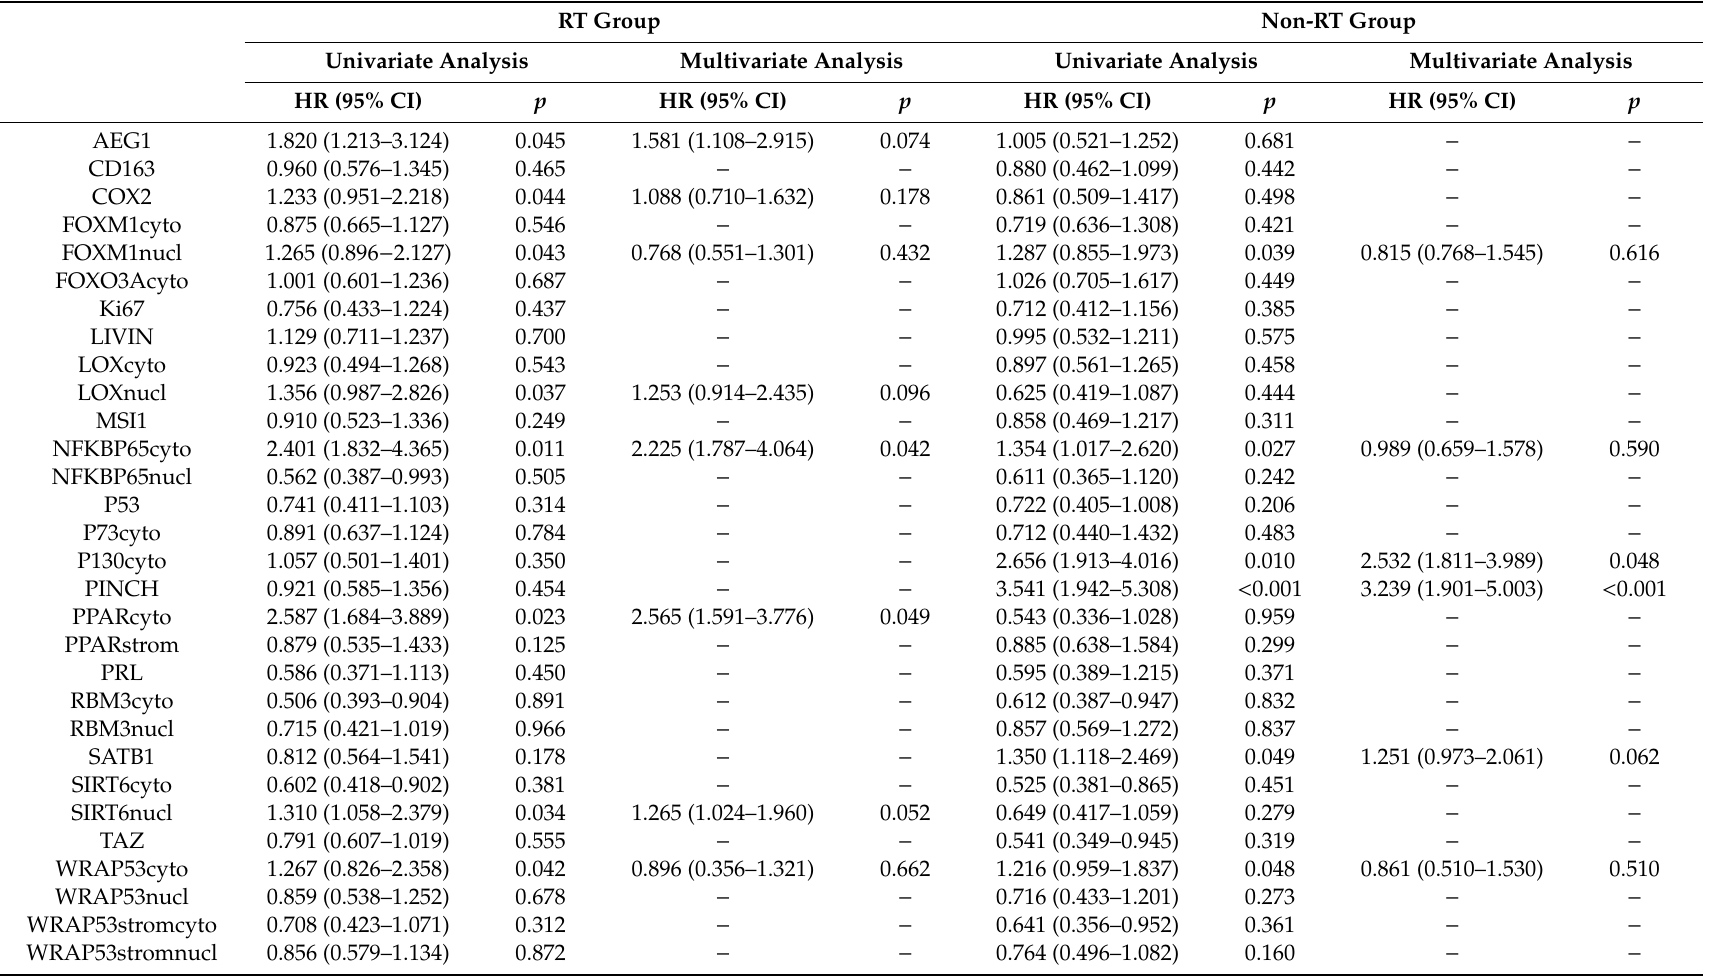
Table 2. Univariate and multivariate Cox proportional hazard models for overall survival of di ff erent biomarkers in biopsies. RT Group Non-RT Group Univariate Analysis Multivariate Analysis Univariate Analysis Multivariate